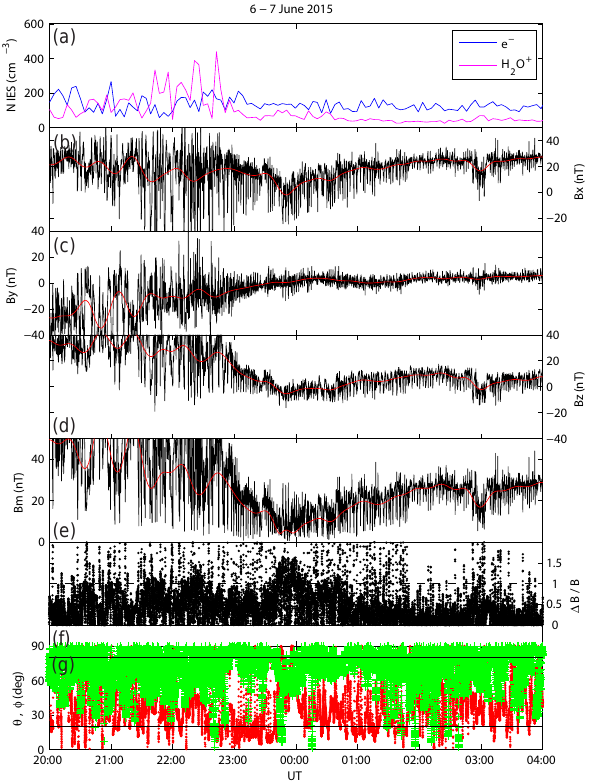
Figure 9. Zoom in on two intervals with different mirror mode waves. From top to bottom the magnetic field components; the mag- netic field strength with overplotted in red the MIP electron density (left) or the LAP P (cid:48) current. The bottom panels shows the angles θ and φ from the MM determination procedure. The inset in the left column shows a blow up of a short interval which shows that the MIP electron density is in anti-phase with the non-filtered B m